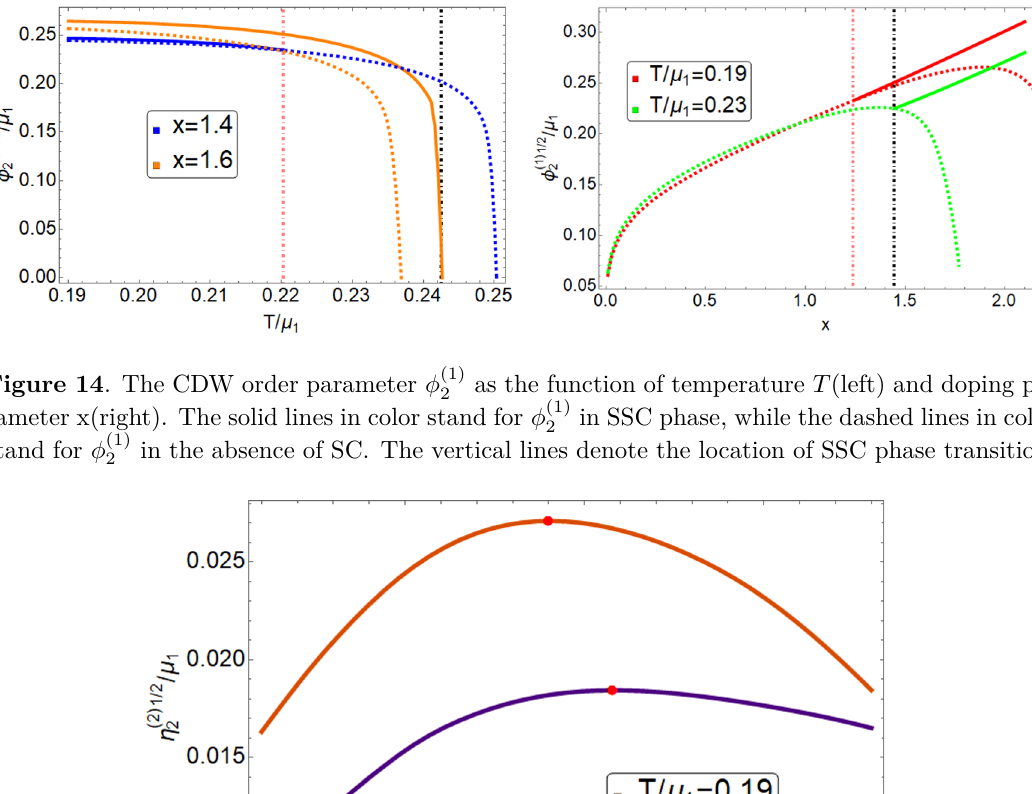
and the ratio of uniform SC order 2 /φ (1) 2 2